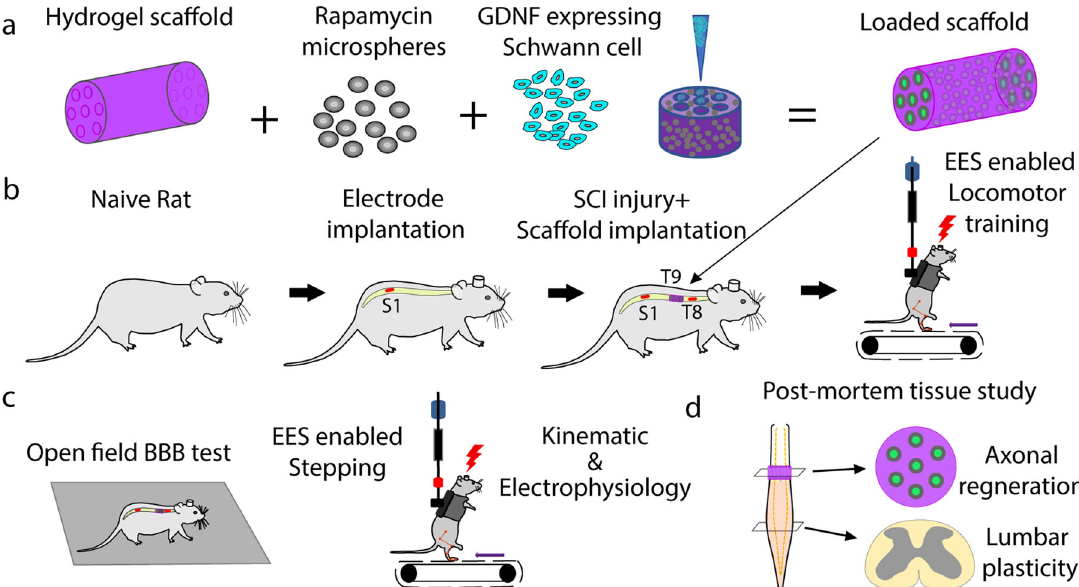
Fig. 1 Experimental methods and study design. a Preparation of 7 channel OPF + hydrogel scaffold containing rapamycin microspheres and channels loaded with GDNF expressing Schwann cells. b In vivo experimental model with implantation of the electrodes and scaffold following complete transection (T9). There were three groups of rats that received a T9 transection with epidural electrical stimulation (EES only), T9 transection with scaffold placement (scaffold only), and transection with scaffold placement and EES (combined therapy). c Following SCI and implantations, all rats received EES-enabled motor training on a treadmill with outcome collected as open fi eld BBB score, kinematic, and electrophysiology during EES-enabled stepping on treadmill. d At the end of the experiment, axonal regeneration through the scaffold and change in plasticity across lumbosacral spinal cord were